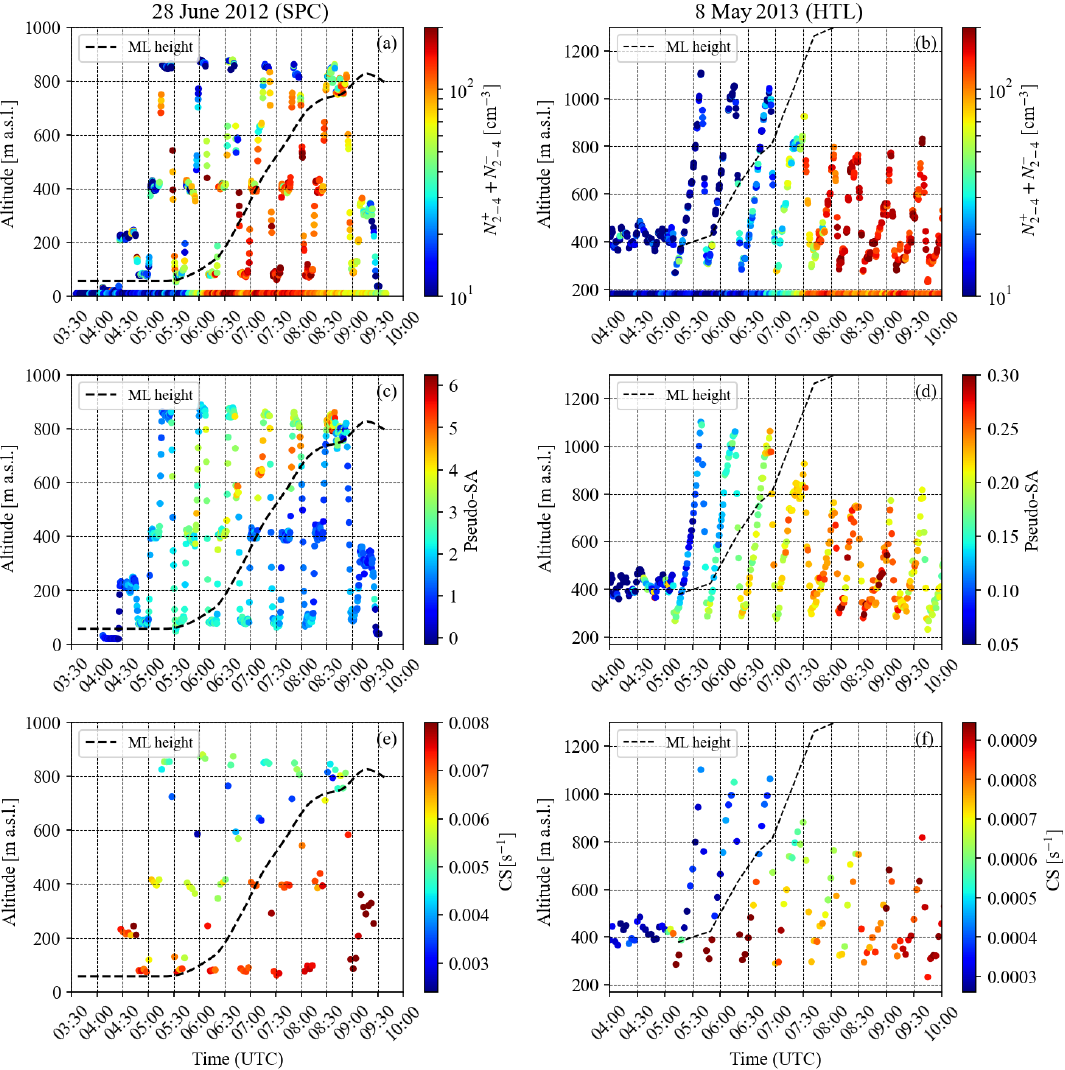
Figure 4. Time evolution of selected variables as a function of height in SPC on 28 June 2012 and HTL on 8 May 2013. Panels (a) and (b) show the intermediate ion number concentration from SPC and HTL. Ground-based measurements as well as measurements from the Zeppelin are shown. Panels (c) and (d) show the pseudo-SA from SPC and HTL. Panels (e) and (f) show the CS. Height of the mixed layer is shown in all